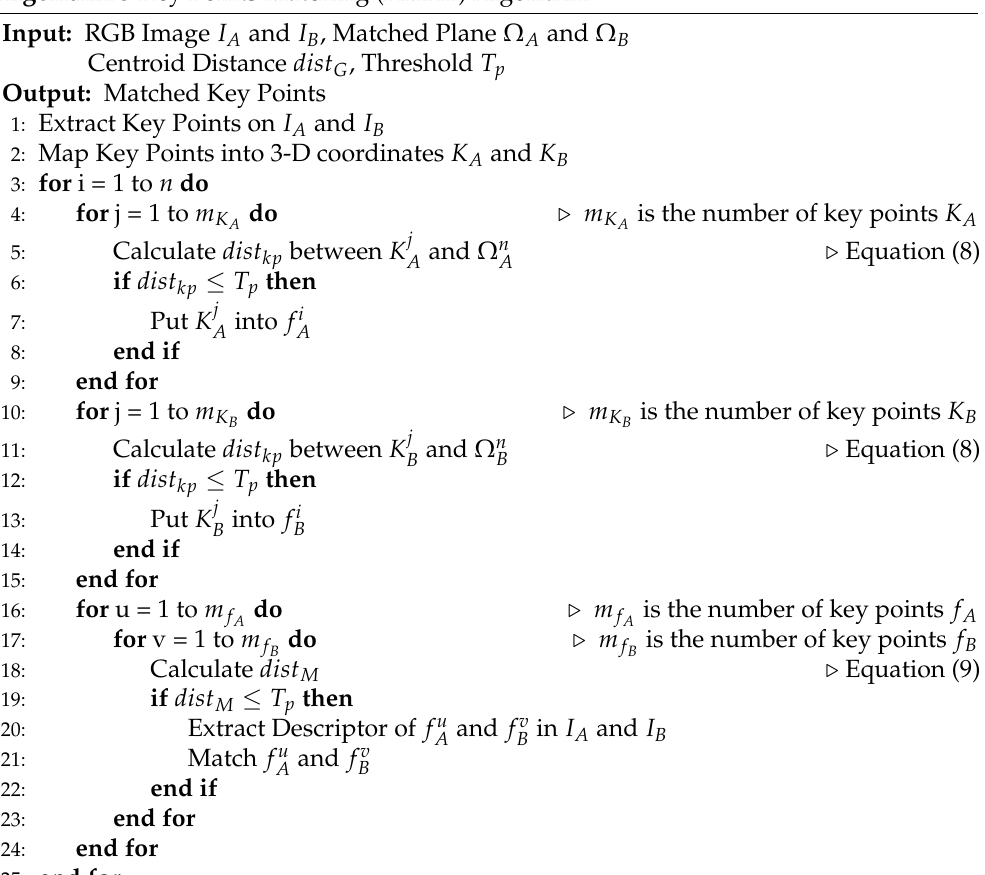
Algorithm 3 Key Points Matching (KMAT)